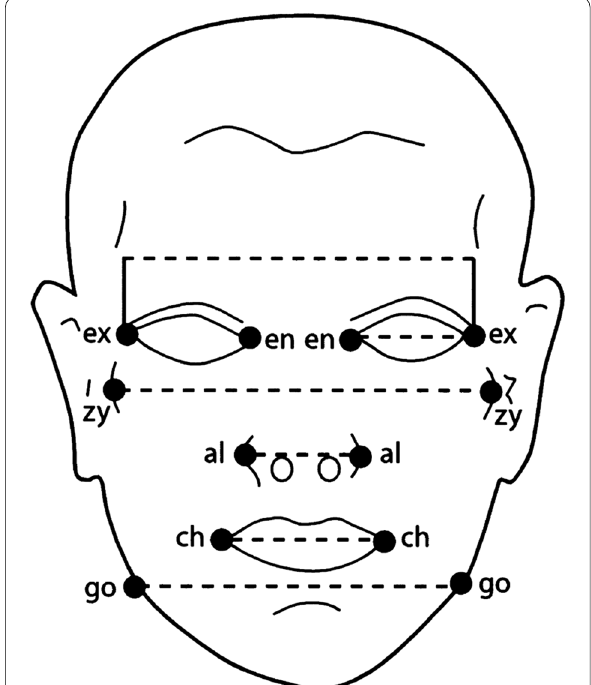
Fig. 2 Measurements on the frontal aspect of the face: intercanthal width (en-en); biocular width (ex-ex); eye fissure width (en-ex); face breadth (zy-zy); mandibular width (go-go); morphological nose width (al-al); mouth width (ch-ch) (Farkas et al.